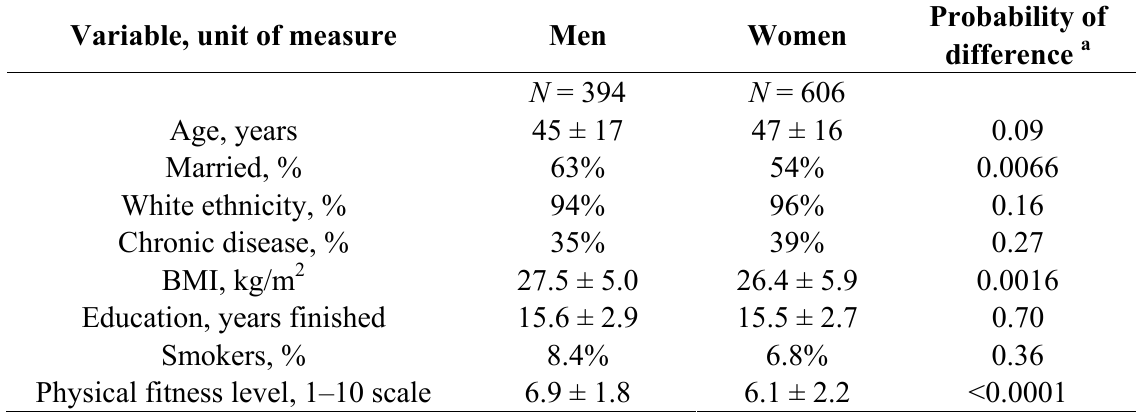
Table 1. Subject characteristics by gender (mean ± standard deviation) of community